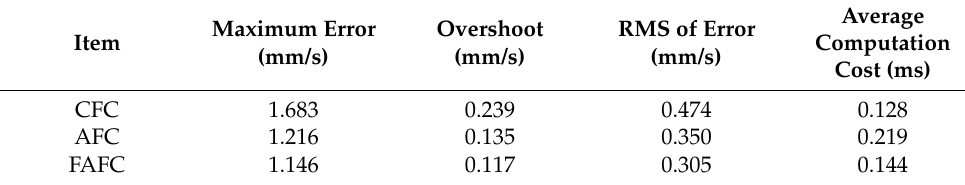
Table 6. Performance of CFC, AFC, and FAFC under Case (200, 175, 191, 50).